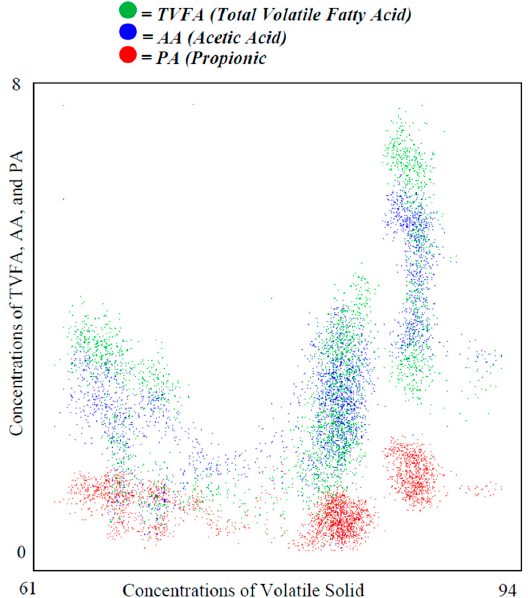
Figure 5. A conventional scatter plot for representing the data of three dependent variables (concentrations of total volatile fatty acids (TVFA), acetic acid (AA) and propionic acid (PA)) against the concentration of volatile solids. Each dependent variable consists of 2885 data points. The ranges of TVFA, AA and PA are [0, 8], [0, 5], and [0, 5], respectively. Due to over ‐ plotting, the large number of data points and the multi ‐ variable environment, this plot itself does not provide direct useful information about data clusters. This is the major drawback of using a scatter plot for representing multi ‐ variable big data.